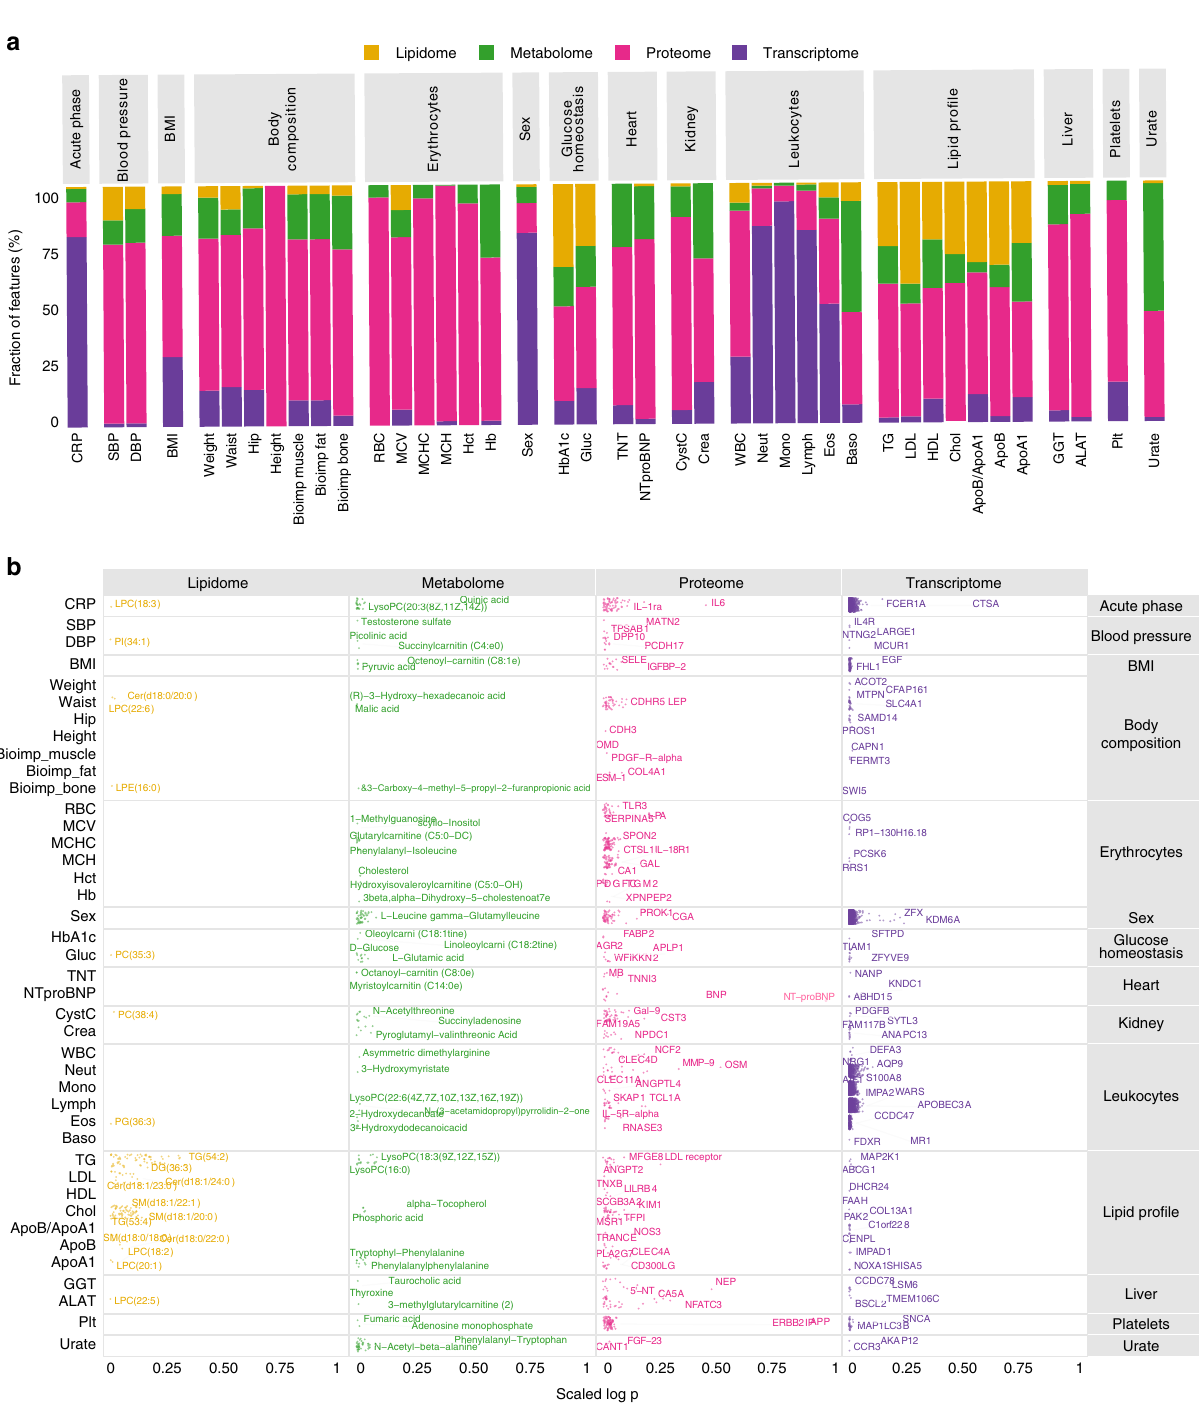
Fig. 5 Mixed-effect modeling of four omics datasets versus clinical parameters. a Bar plot of the distribution of the most signi fi cant results from mixed- effect modeling for each of the clinical variables compared to features from the proteome, transcriptome, metabolome and lipidome. b Visualization of the top two most signi fi cant features for each clinical data across omics colored by omics type. Multiple test corrections have been applied for p values using Benjamini and Hochberg method. Number of samples: metabolome ( n = 94), lipidome ( n = 48), proteome ( n = 90), transcriptome ( n =